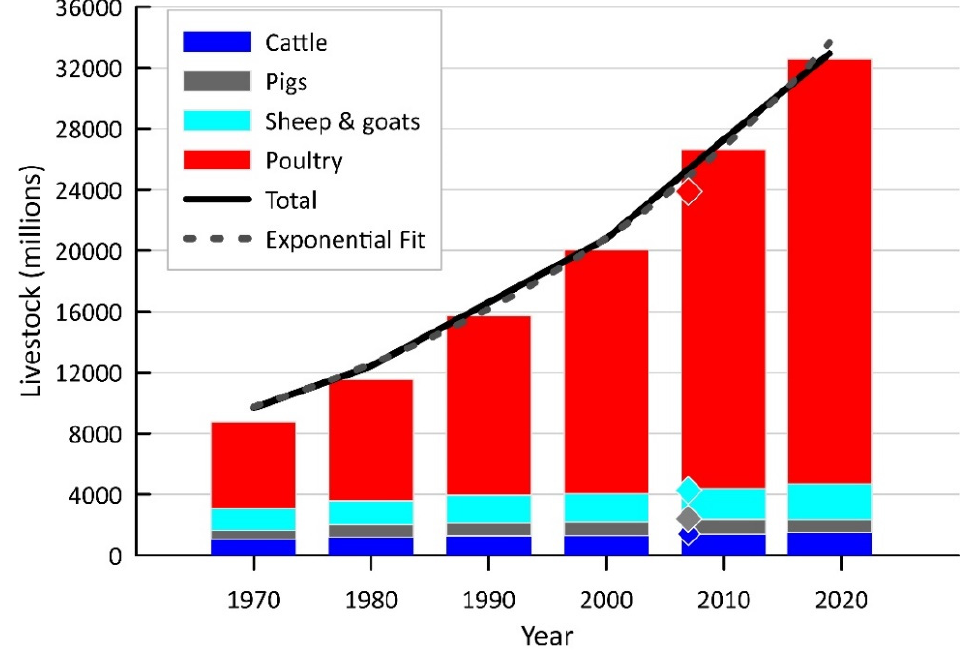
Table 1. Global livestock numbers for selected species (in millions) for 1970–2019 [12] and for 2007 [10]. Total includes rabbits, ducks, turkey, rodents, horses, buffalo, and asses. Human population taken from [14]. and nitrous oxide (N 2 O) (6% RF) [7]. To simplify issues arising from complications of the radiative potential of different gases or their different lifetimes, emissions are often expressed as carbon dioxide equivalents, CO 2e . Agriculture is responsible for ~22–26% of global warming potential (GWP) arising from GHG emissions [4,8] with the food supply chain accounting for up to 37% [8]. Esti- mates of GHG emissions attributable to the ~17–24 billion domestic animals assigned as food at any time (Table 1 and Figure 1), have a wide range from 8% to 26% of total GHG emis- sions [4,9,10], i.e., 4.7–13.7 GtCO 2e yr − 1 depending on the assumptions and the time range. 57% from animal-based food (including livestock feed) [11].